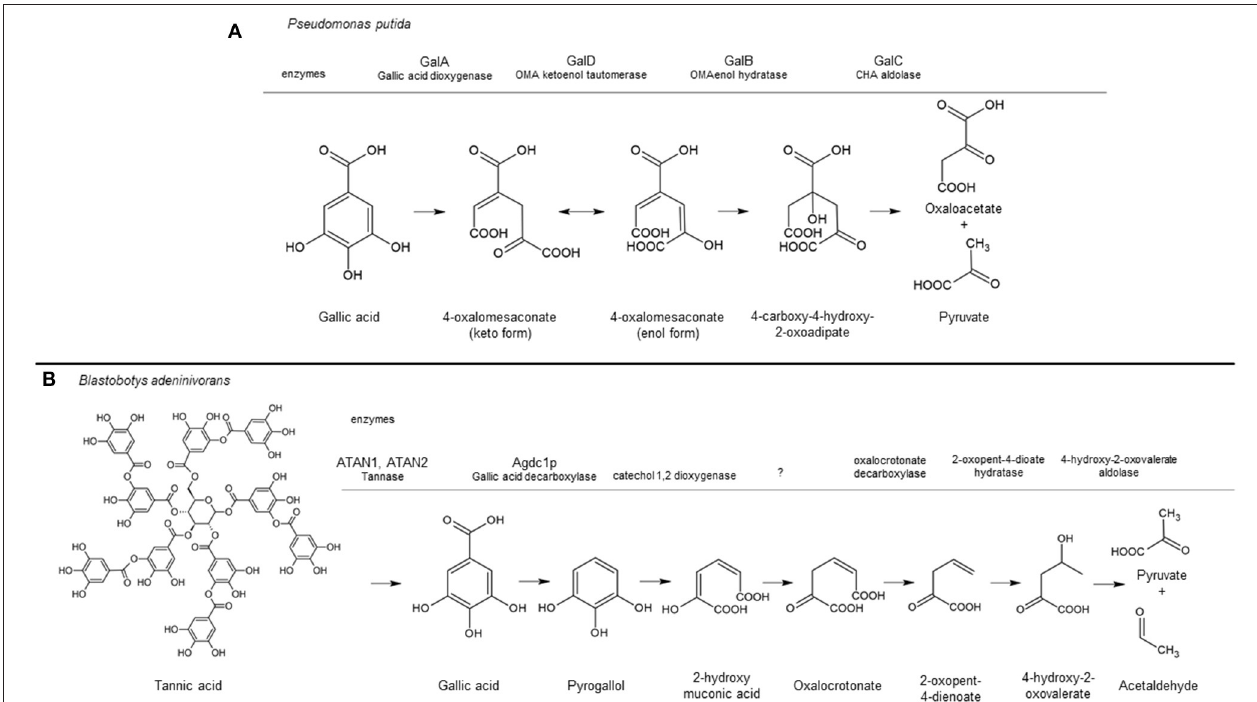
FIGURE 1 | Tannic acid/gallic acid catabolic pathway in Pseudomonas putida (A) and Blastobotys adeninivorans (B) based on Nogales et al. (2011) and Meier et al. (2017) , respectively. The aromatic converting enzymes are indicated above the gray line corresponding to their conversion step in the pathway, including the enzyme name when identified. A question mark indicates the enzyme has not being identified. This figure was made using ACD/ChemSketch Freeware, version 2019.2.1, Advanced Chemistry Development, Inc., Toronto, ON, Canada, www.acdlabs.com,